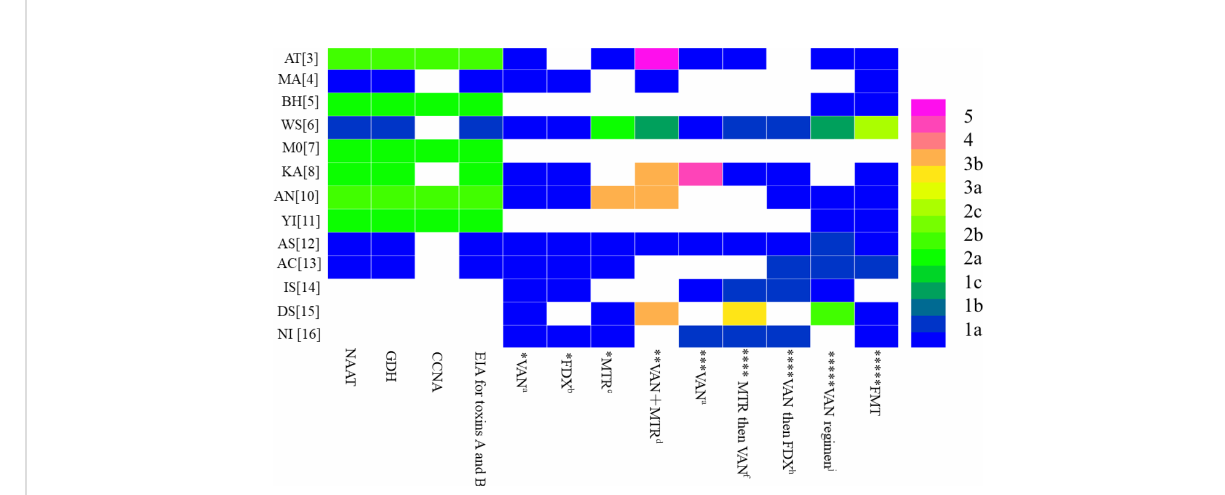
FIGURE 2 Distribution of the highest level of evidence to support similar recommendations for the diagnosis and therapy of Clostridioides dif fi cile infection among the included guidelines. * represents the patient's fi rst infection with C. dif fi cile and is not serious; ** represents the patient's fi rst infection with C. dif fi cile and is Fulminant; *** represents thepatient's fi rst infection with C. dif fi cile and is serious; **** represents the patient's fi rst recurrence of C. dif fi cile infection; ***** represents the patient's multiple recurrent ofC. dif fi cile